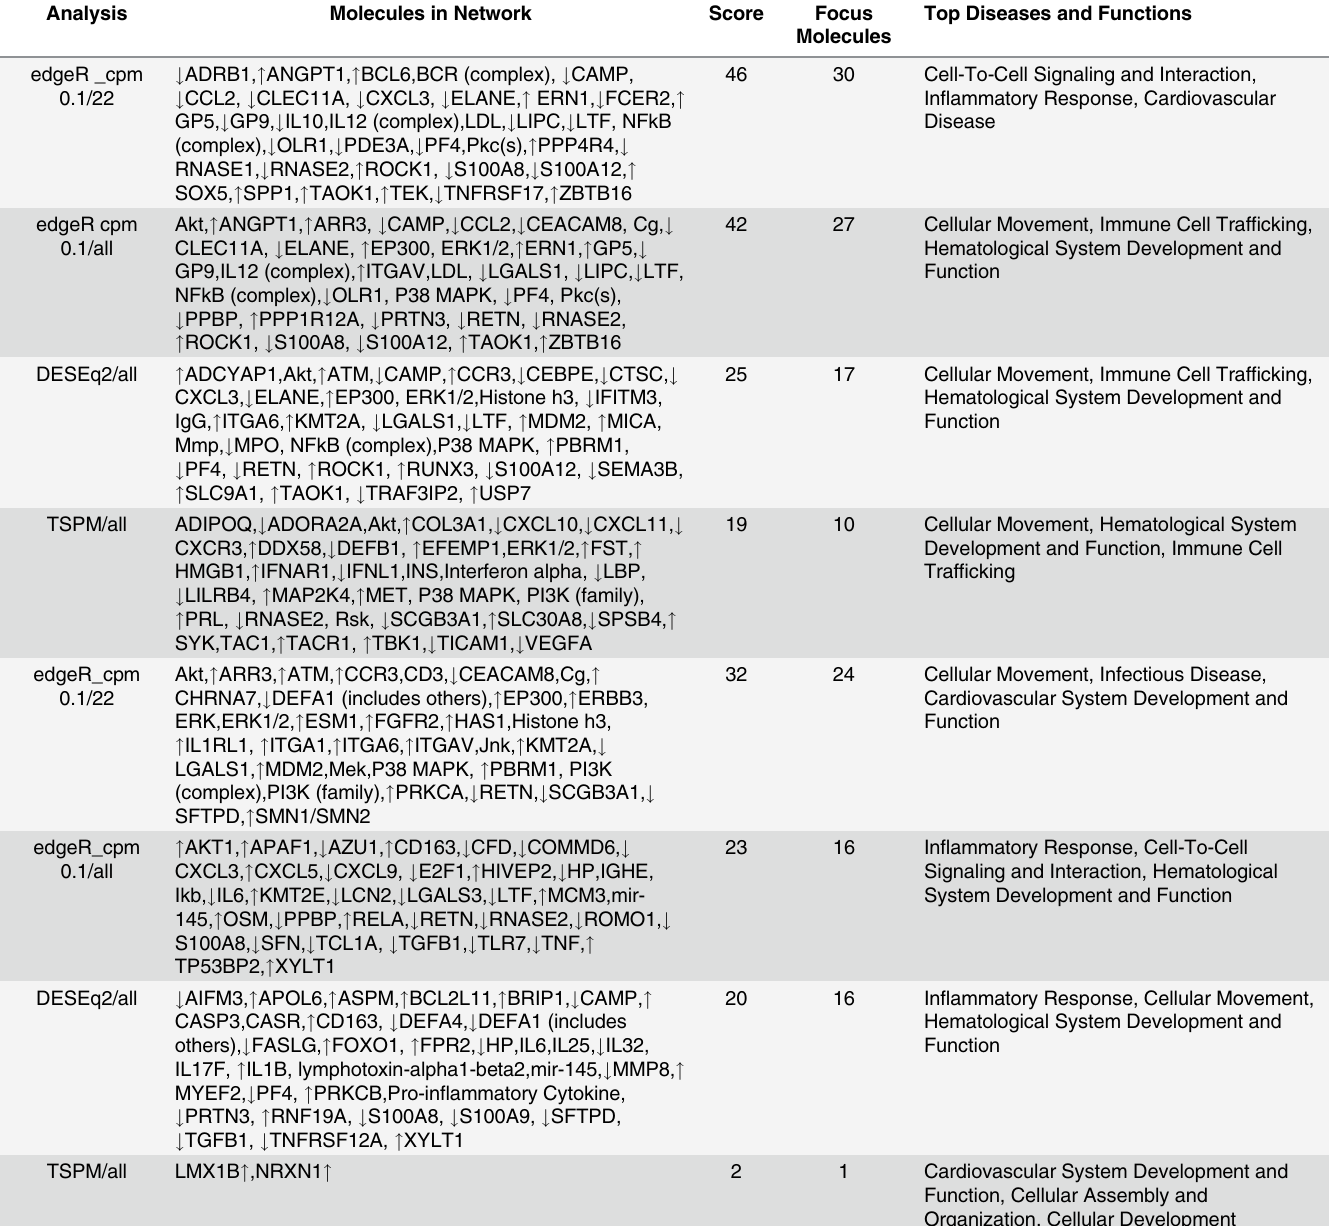
Table 3. Predicted top molecular networks affected by LGG treatment after 28 day intervention. Molecules in Network Score Focus